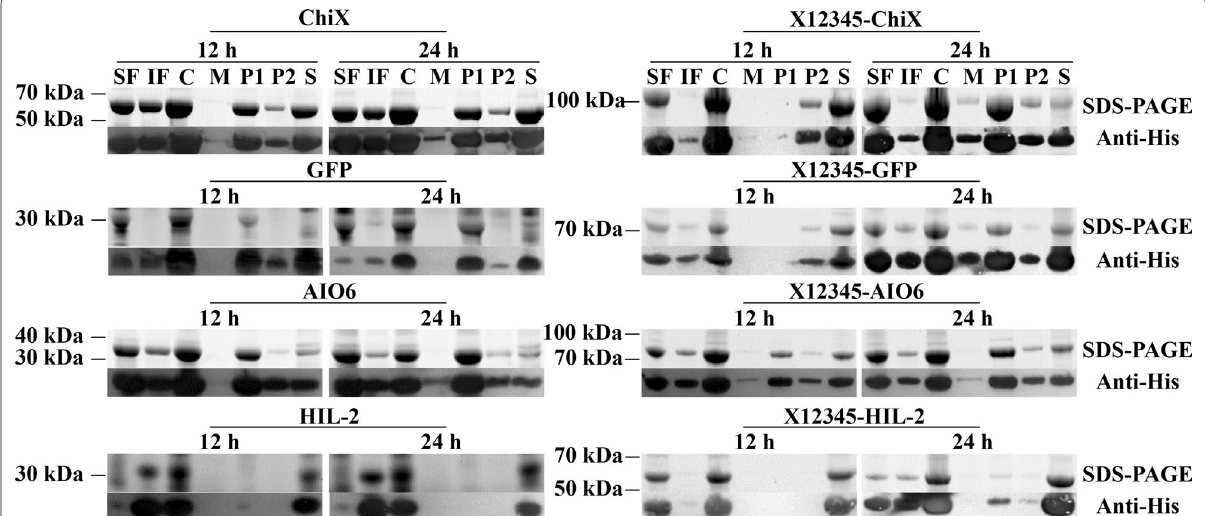
Fig. 3 Subcellular locations of the X12345–ChiX, GFP, AIO6, hIL-2. Each of the for ‘passenger’ proteins, AIO6, hIL-2, and GFP, were expressed in E. coli BL21(DE3) harboring pET28a( ) or pX12345LT. The lane loadings are directly comparable. SF soluble fraction, IF insoluble fraction, C cells, M + medium, P1 periplasm fraction (hypertonic solution fraction), P2 periplasm fraction (hypotonic solution fraction),